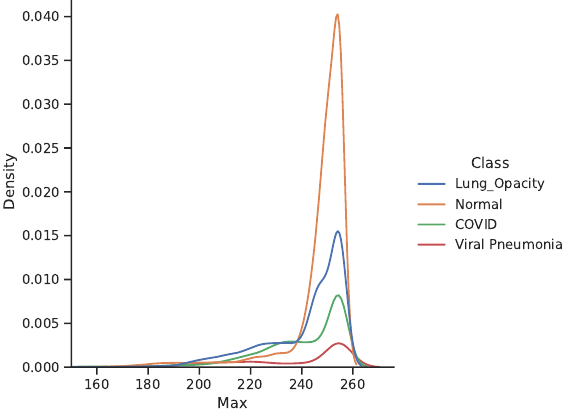
Figure 5. Maximum RGB color intensity distributions for the four X-ray image classes. The distribution of the whole dataset is very akin to the individual healthy and lung opacity patient images, this is because both classes contribute the most to the dataset relative to the remaining classes of viral pneumonia and COVID-19. Separating by class, we can visualise that the mean, maximum, and minimum values vary according to the image class. Amongst all classes, viral pneumonia shows a Gaussian-like distribution across the three different distributions while COVID-19 shows a nearly normal distribution. The maximum value possible for an image is 255 and most classes peak around it. From Figure 4, viral pneumonia is the class that has the highest samples with lower maximum values. Most samples’ RGB colour intensities are within the 200–225 range. Normal (Healthy) and lung opacity images show a very similar distribution of their mean values. This may be due to the two classes having the most sample X-ray images in the dataset. Moreover, the different peaks in the distribution could be attributed to the image source (e.g., two different hospitals where instrument noise, compression error or some other phenomena may have contributed to the veracity of the underlying signals). Figure 4 shows a similar distribution with regards to the maximum values as indicated by the local minimum between intensities of 220 to 240. At the same time, normal patients have a peak at 150 and another peak around 250. We observe that the images are in gray-scale, they have the three channels which contain repeated RGB values. A visualised sample images from the dataset are shown in Figure 6 in a rainbow color